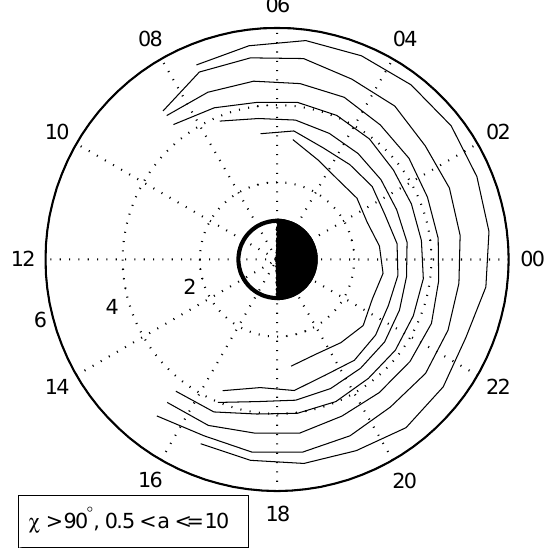
Fig. 8. MLT dependence of mean L t at different ranges of Kp. Curves from outside inward represent the mean PP positions for Kp=0–1, 1–2, 2–3, 3–4, 4–5, 5–6, and 6–, respectively. Data from 2001–2003 are used.